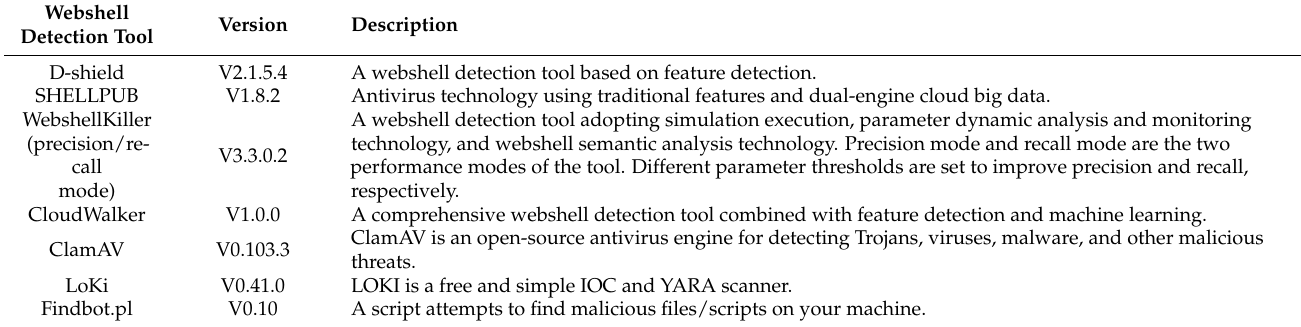
Table 5. Webshell detection